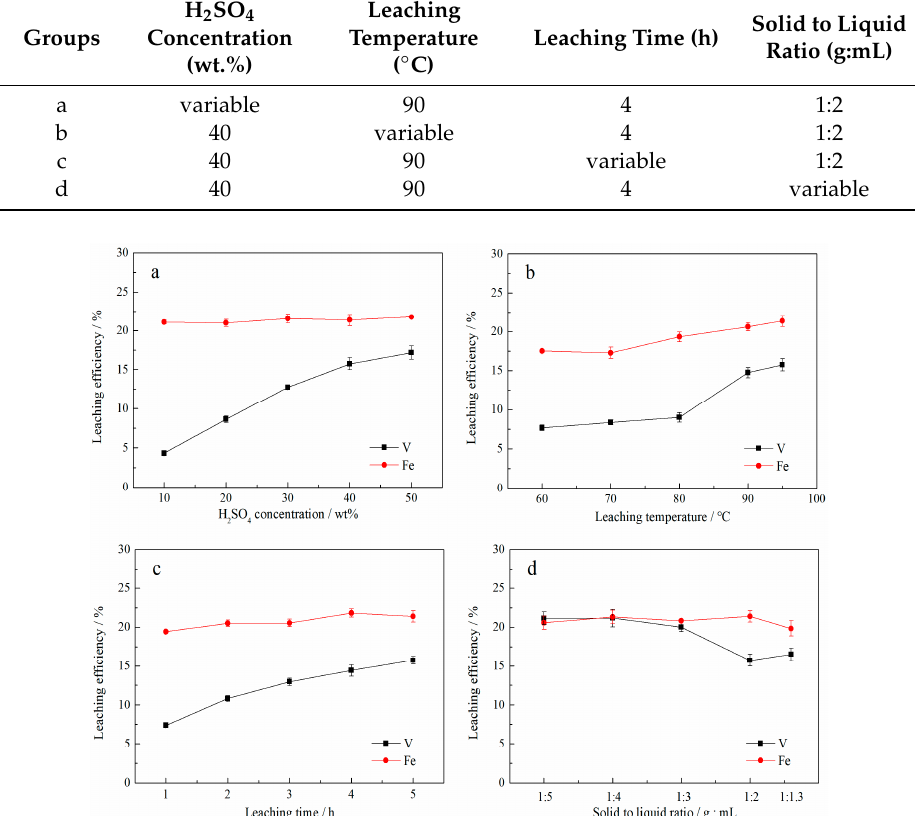
Figure 1. The leaching efficiency of V and Fe from the raw ore at different leaching conditions. Variables: ( a ) the H 2 SO 4 concentration; ( b ) the leaching temperature; ( c ) the leaching time; ( d ) the solid to liquid ratio.